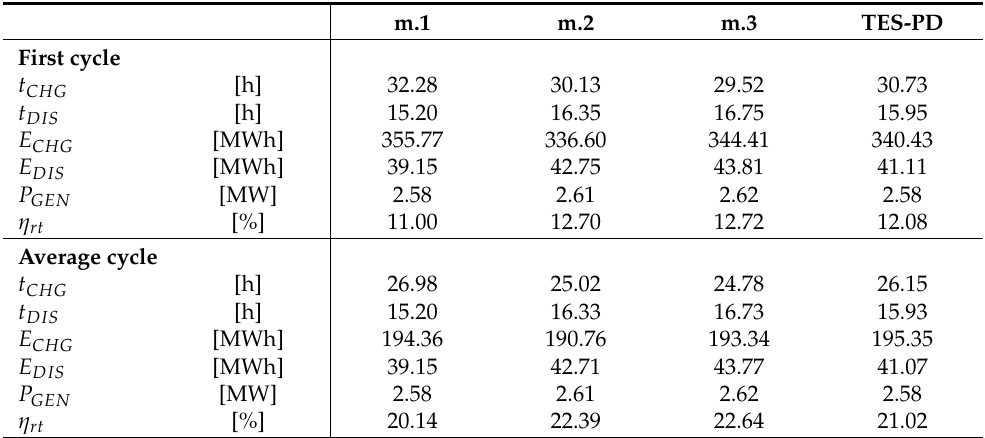
Table 3. Test of all models in their original formulation. In this case, the properties for m.1 and m.3 were assumed constant (evaluated at T mean ), while m.2 and TES-PD assumed variable properties for each layer, according to the local temperature. The heat loss coefficient U i was set equal